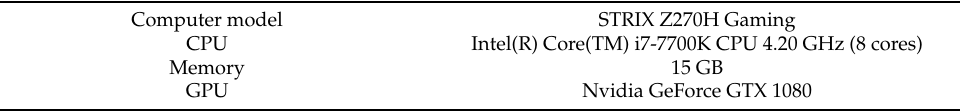
Table 10. Computer configuration applied in our